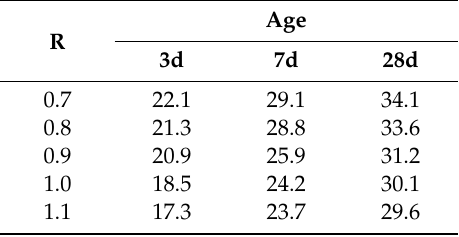
Table 7. Compression strength of concrete at di ff erent ages /